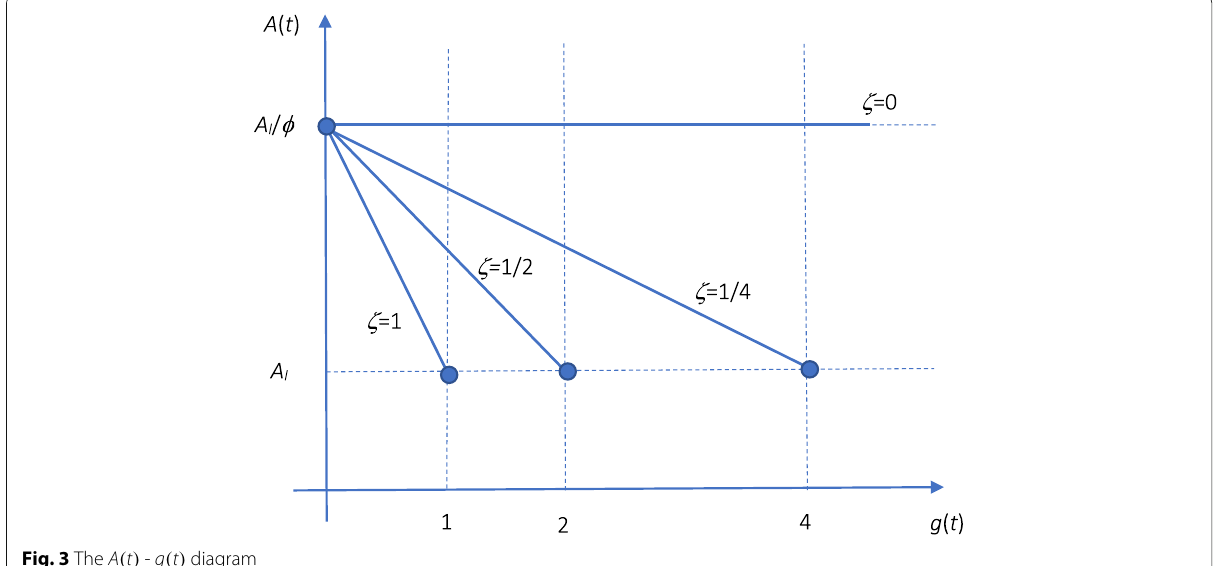
Fig. 3 The A ( t ) - g ( t )